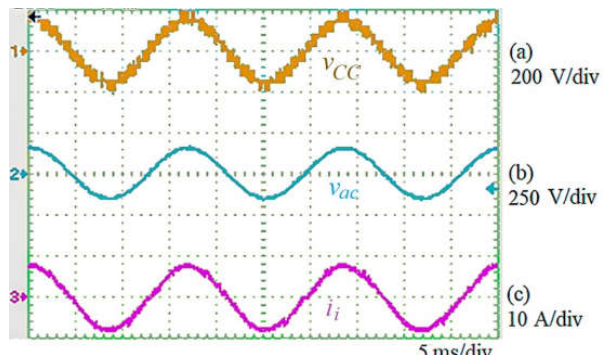
Figure 11. Experimental results for the AC side of the CC: ( a ) AC port voltage of CC; ( b ) utility voltage; ( c ) input current.